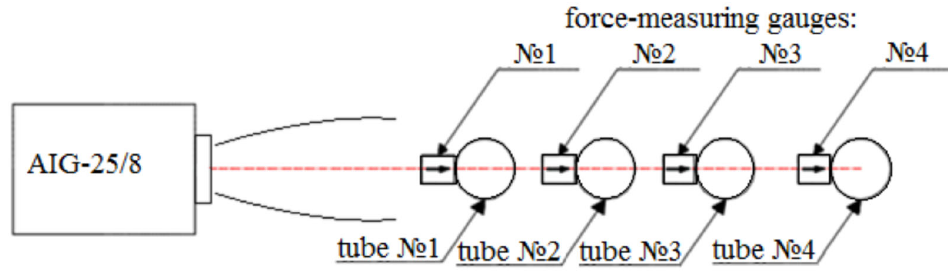
Figure 5. Schematic of force ‐ measuring gauge positioning.